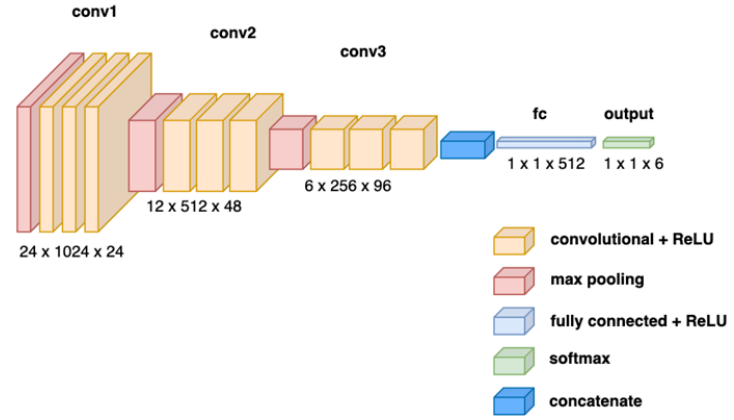
Figure 5. The architecture of purposed convolutional neural network.